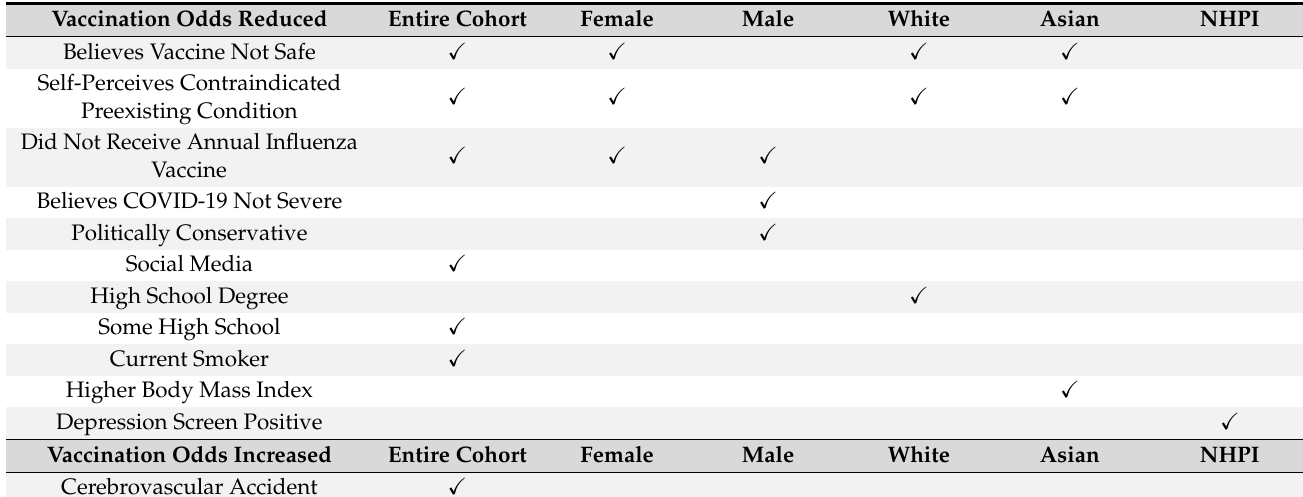
Table 11. Strongest predictors of vaccination acceptance or hesitance amongst neurologic patients, according to multivariable logistic